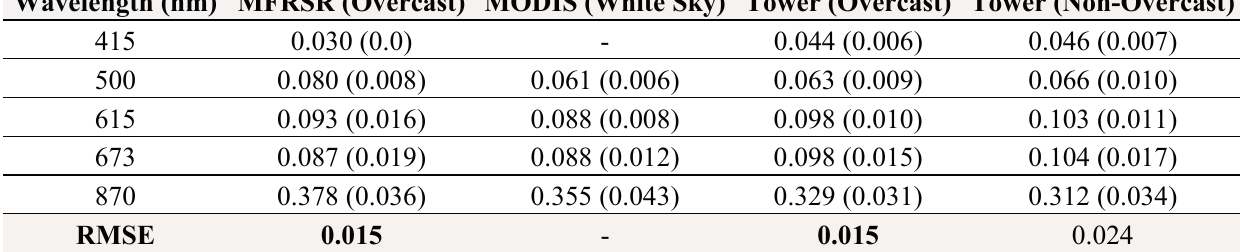
Table 1. Time-averaged albedos and the corresponding standard deviations (in parenthesis) derived from the indicated platforms for the NOAA site. For the tower data, both fully overcast and non-overcast conditions are shown. The MODIS data have been interpolated/extrapolated to the nominal MFRSR wavelengths. The root mean square error (RMSE) is also shown (bottom row) using the MODIS albedos as the reference. The two lowest RMSEs are indicated in